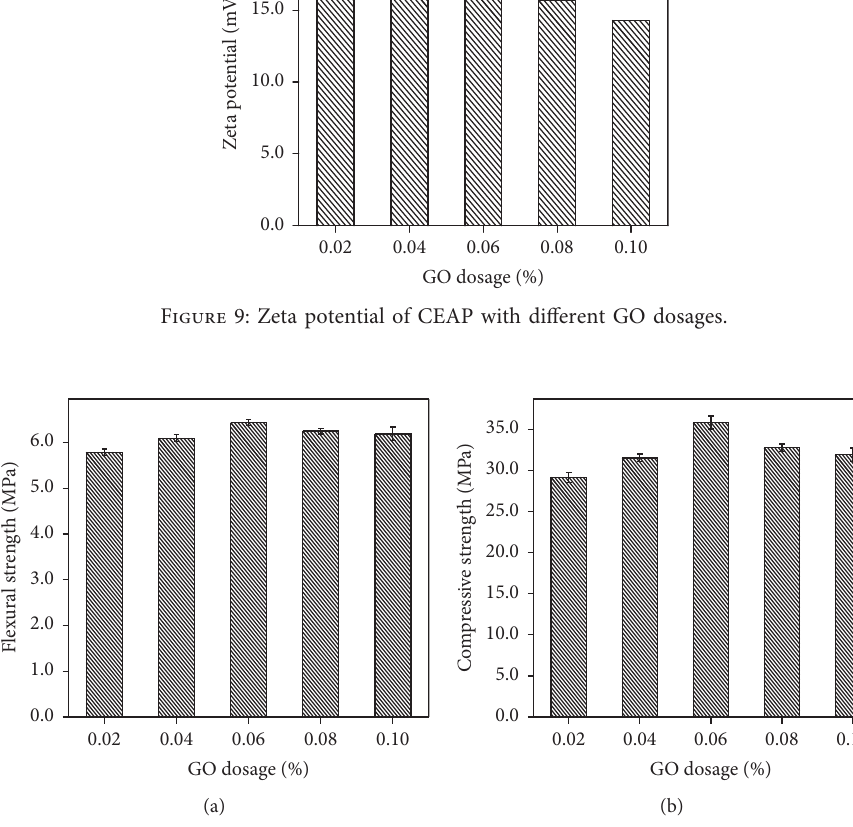
Figure 10: Effects of GO on the strength of CEAP. (a) Flexural strength. (b) Compressive